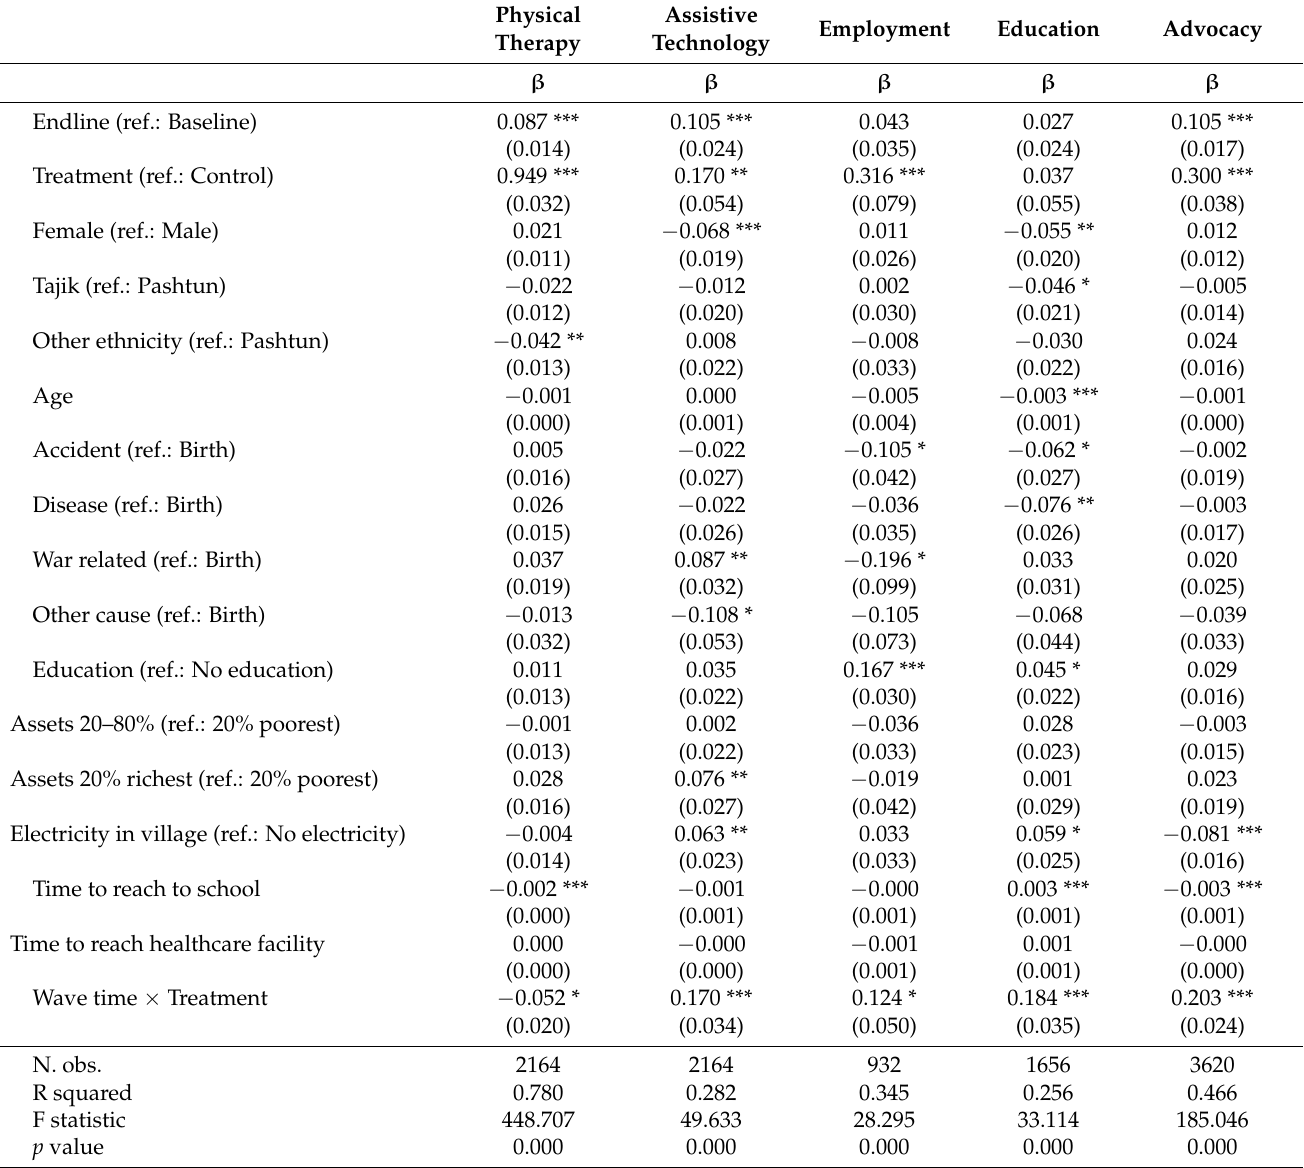
Table 3. Results of linear probability models for access to